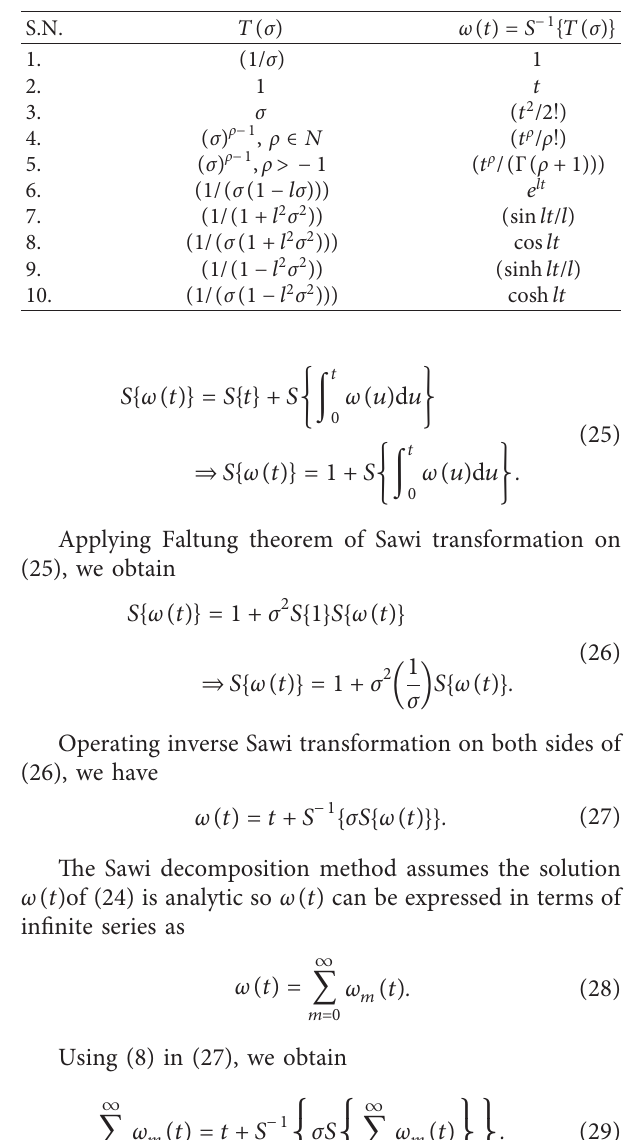
Table 2: Inverse Sawi transformation of frequently used functions [4].